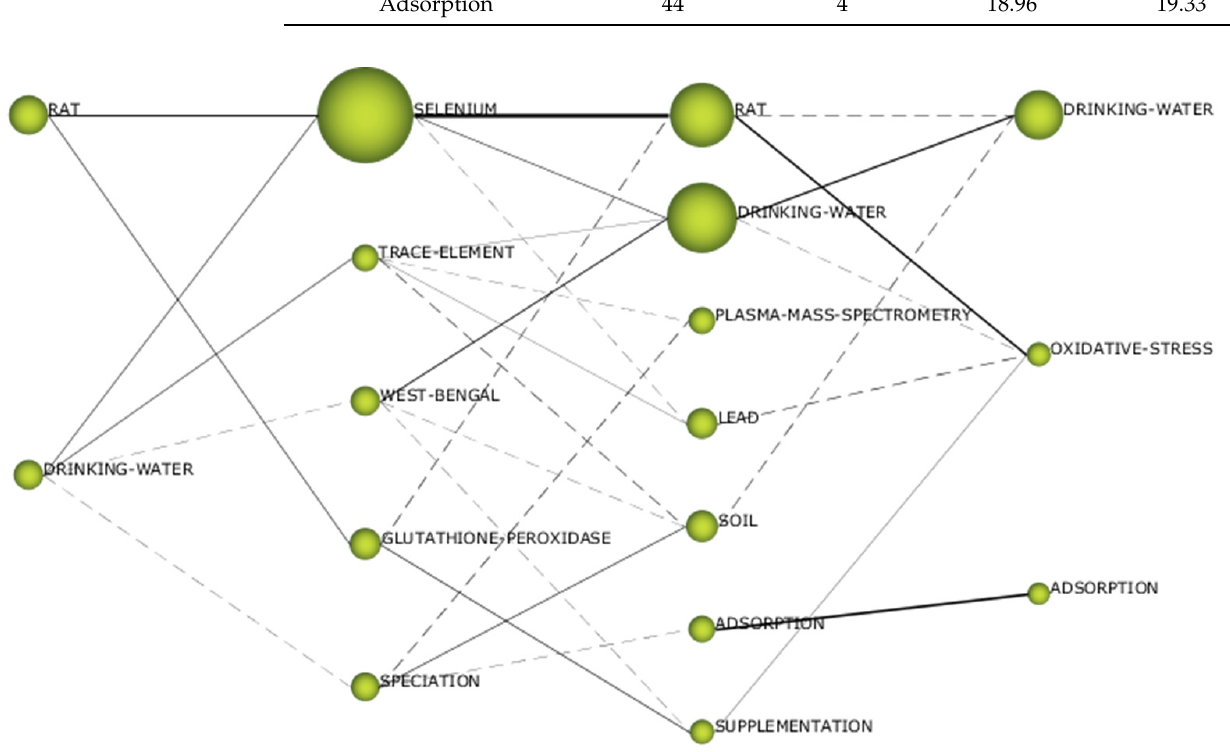
Figure 5. Thematic evolution structure of selenium and drinking water research (1990–2021).